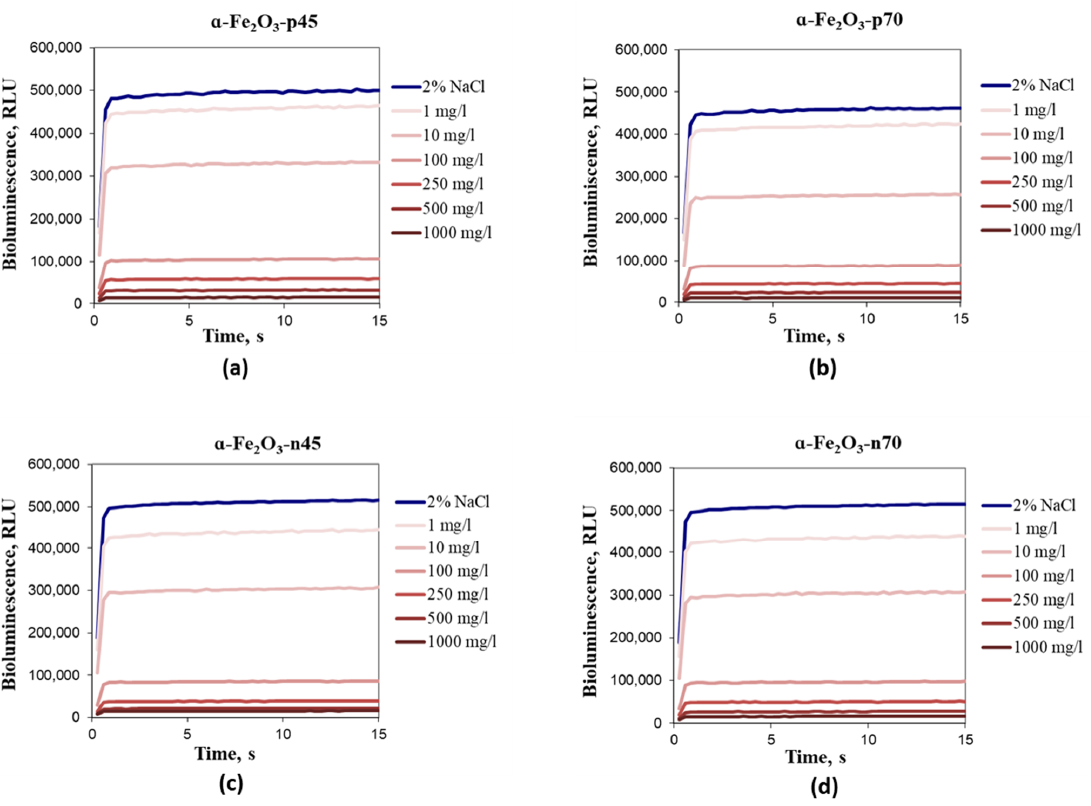
Figure 7. Kinetics of the Vibrio fischeri bioluminescence inhibition upon exposure of bacteria to different concentrations of α -Fe 2 O 3 NPs.